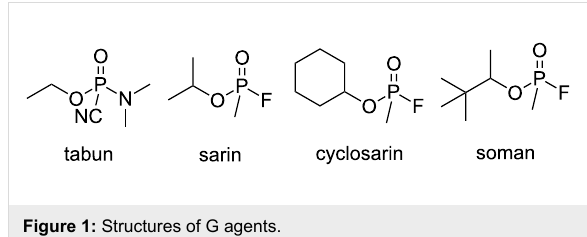
Figure 1: Structures of G